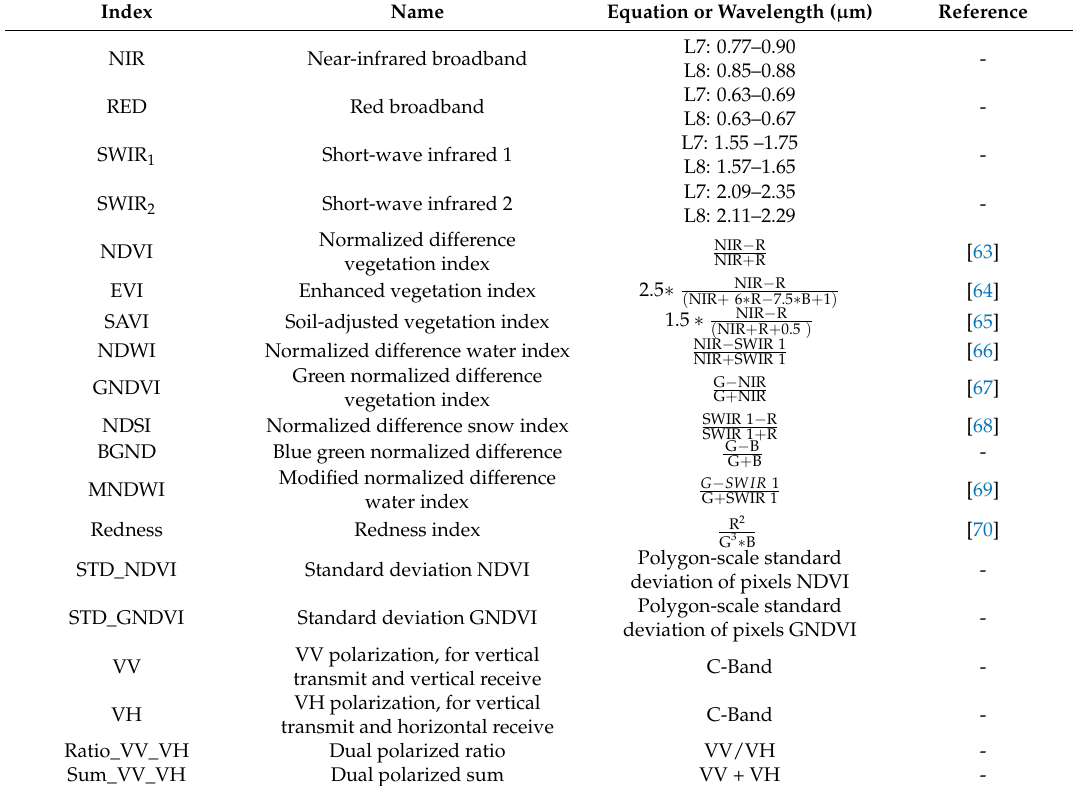
Table 2. Spectral bands, spectral indices from Landsat and SAR backscattering coefficient and indices were used as inputs for the crop classifier. Other broadband wavelength ranges, which are not listed in the table, are B (L7: 0.45–0.52 µ m; L8: 0. 45–0.51 µ m) and G (L7: 0.52–0.60 µ m; L8:0.53–0.59 µ